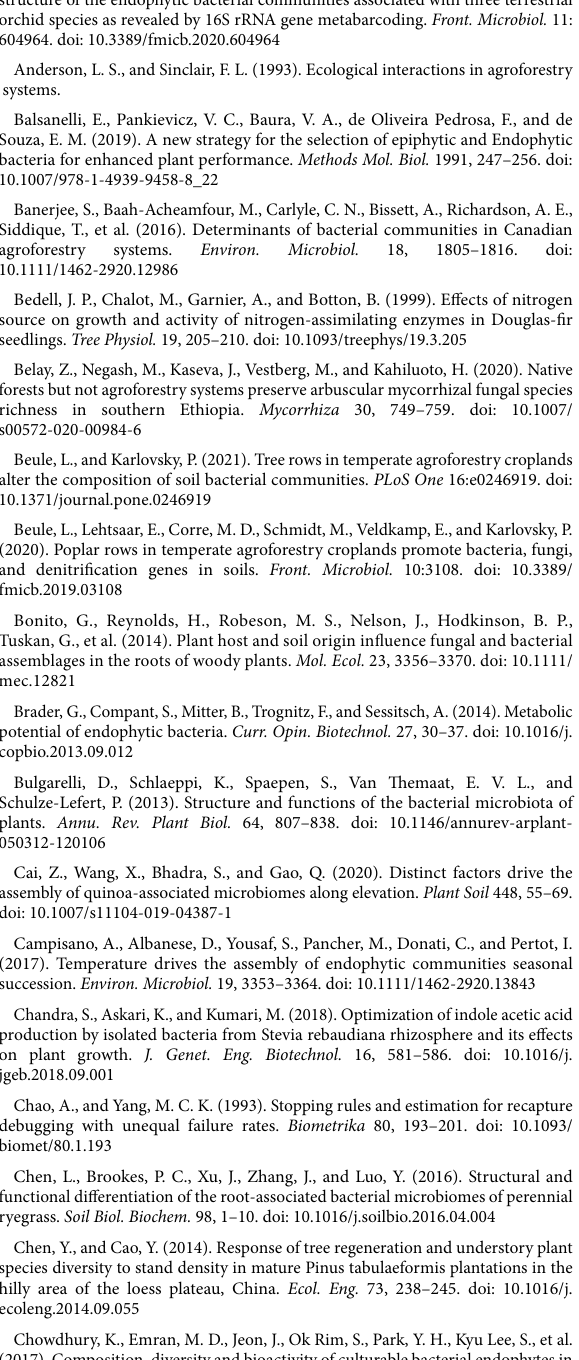
SUPPLEMENTARY FIGURE S8 Student t -test bar plots for different compartments of fungal community of P.n. on genus level. Pk, P.n. - P.k. agroforestry system, Pa, P.n. - P.a. agroforestry system.